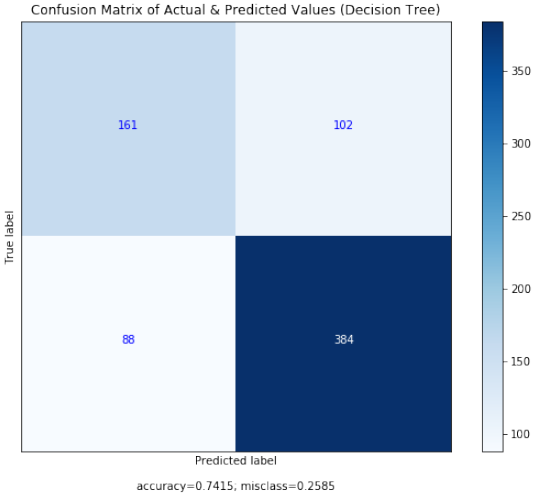
Figure 5. decision tree classifier CM result